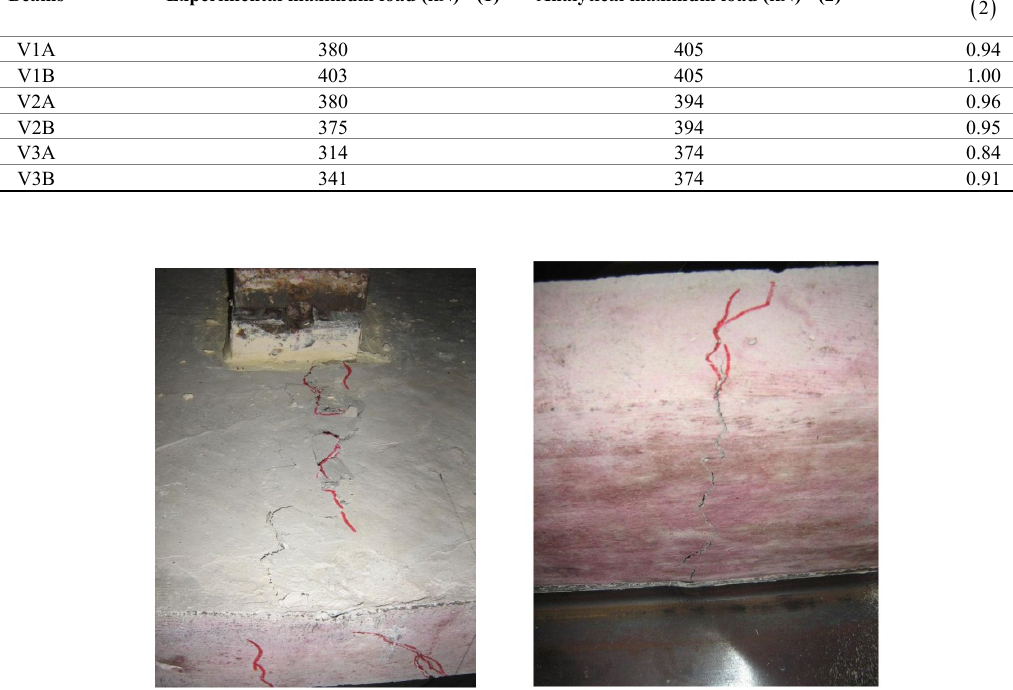
Table 7. Experimental and analytical maximum load obtained for the beams. Beams